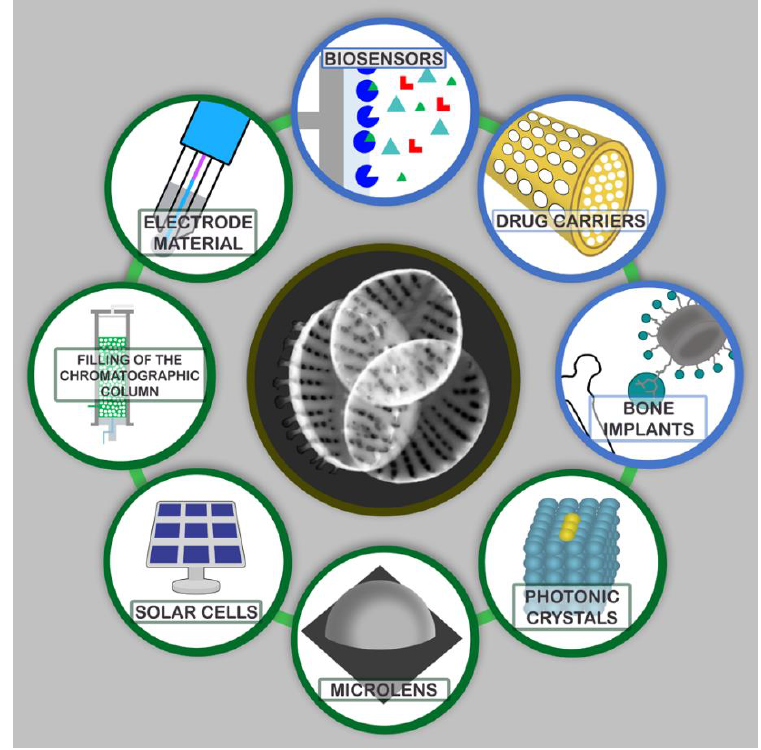
Figure 2. A range of possibilities to use diatomaceous biosilica.